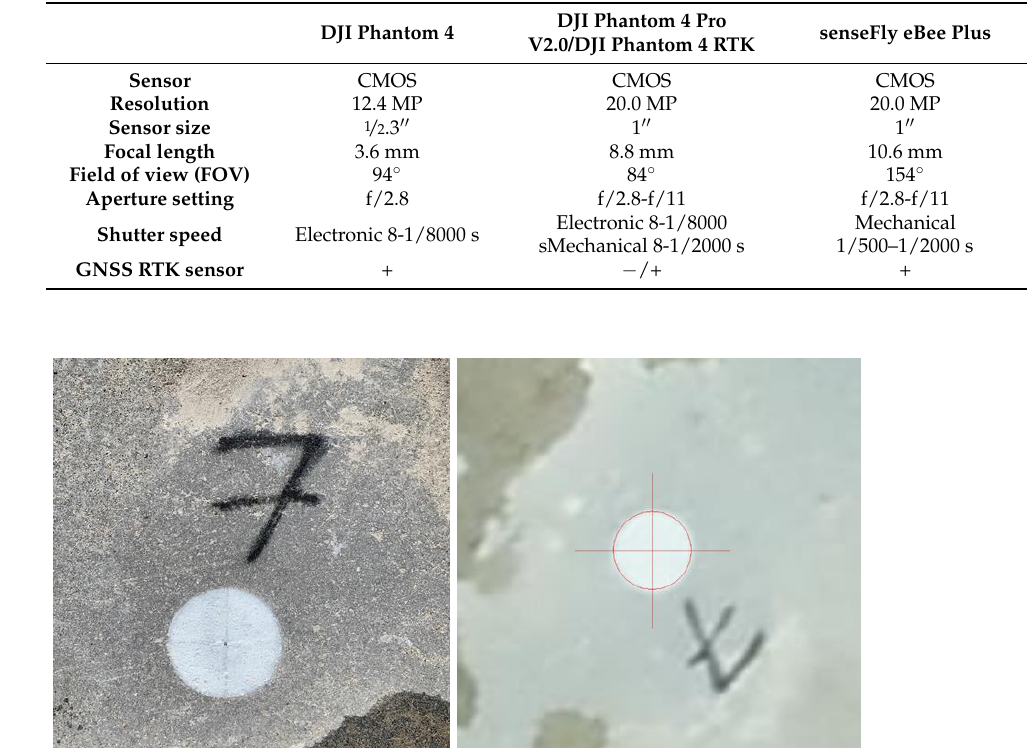
Table 2. UAS camera specifications.